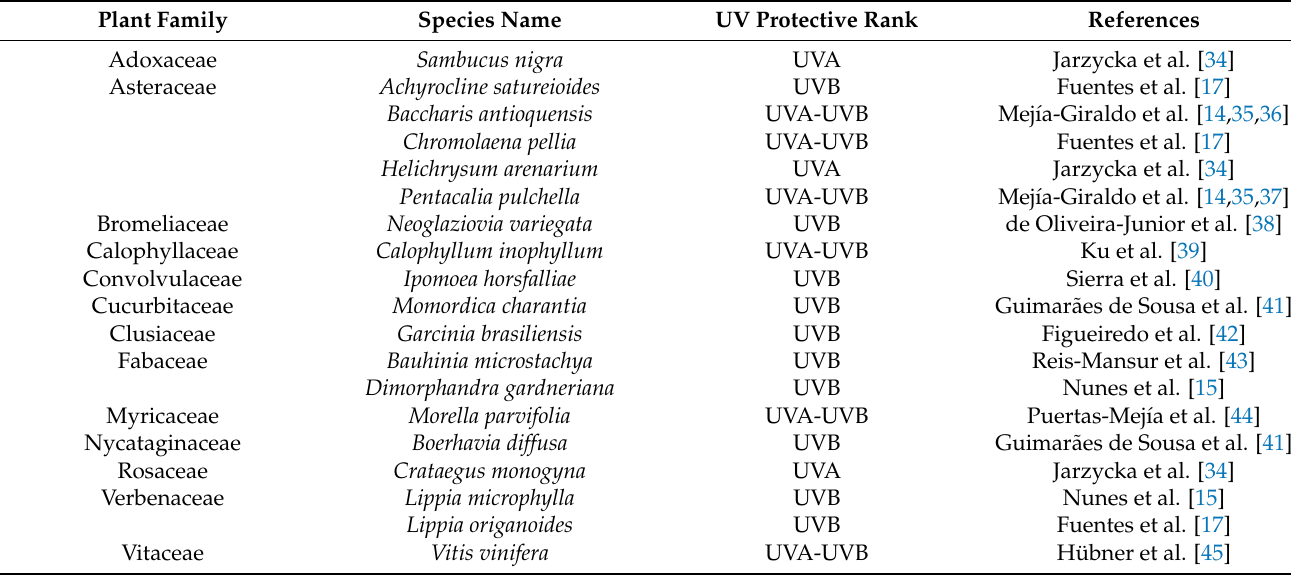
Table 4. Some plant species with reported sunscreen properties †